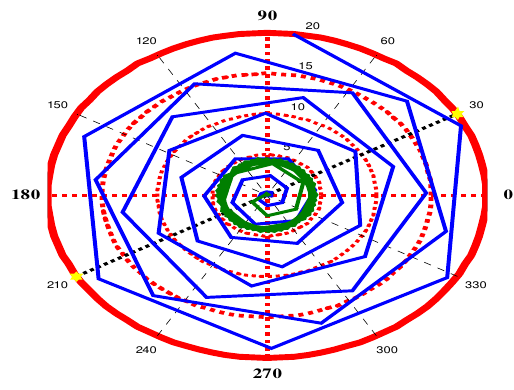
Fig.10. Stability analysis of the WCN system.